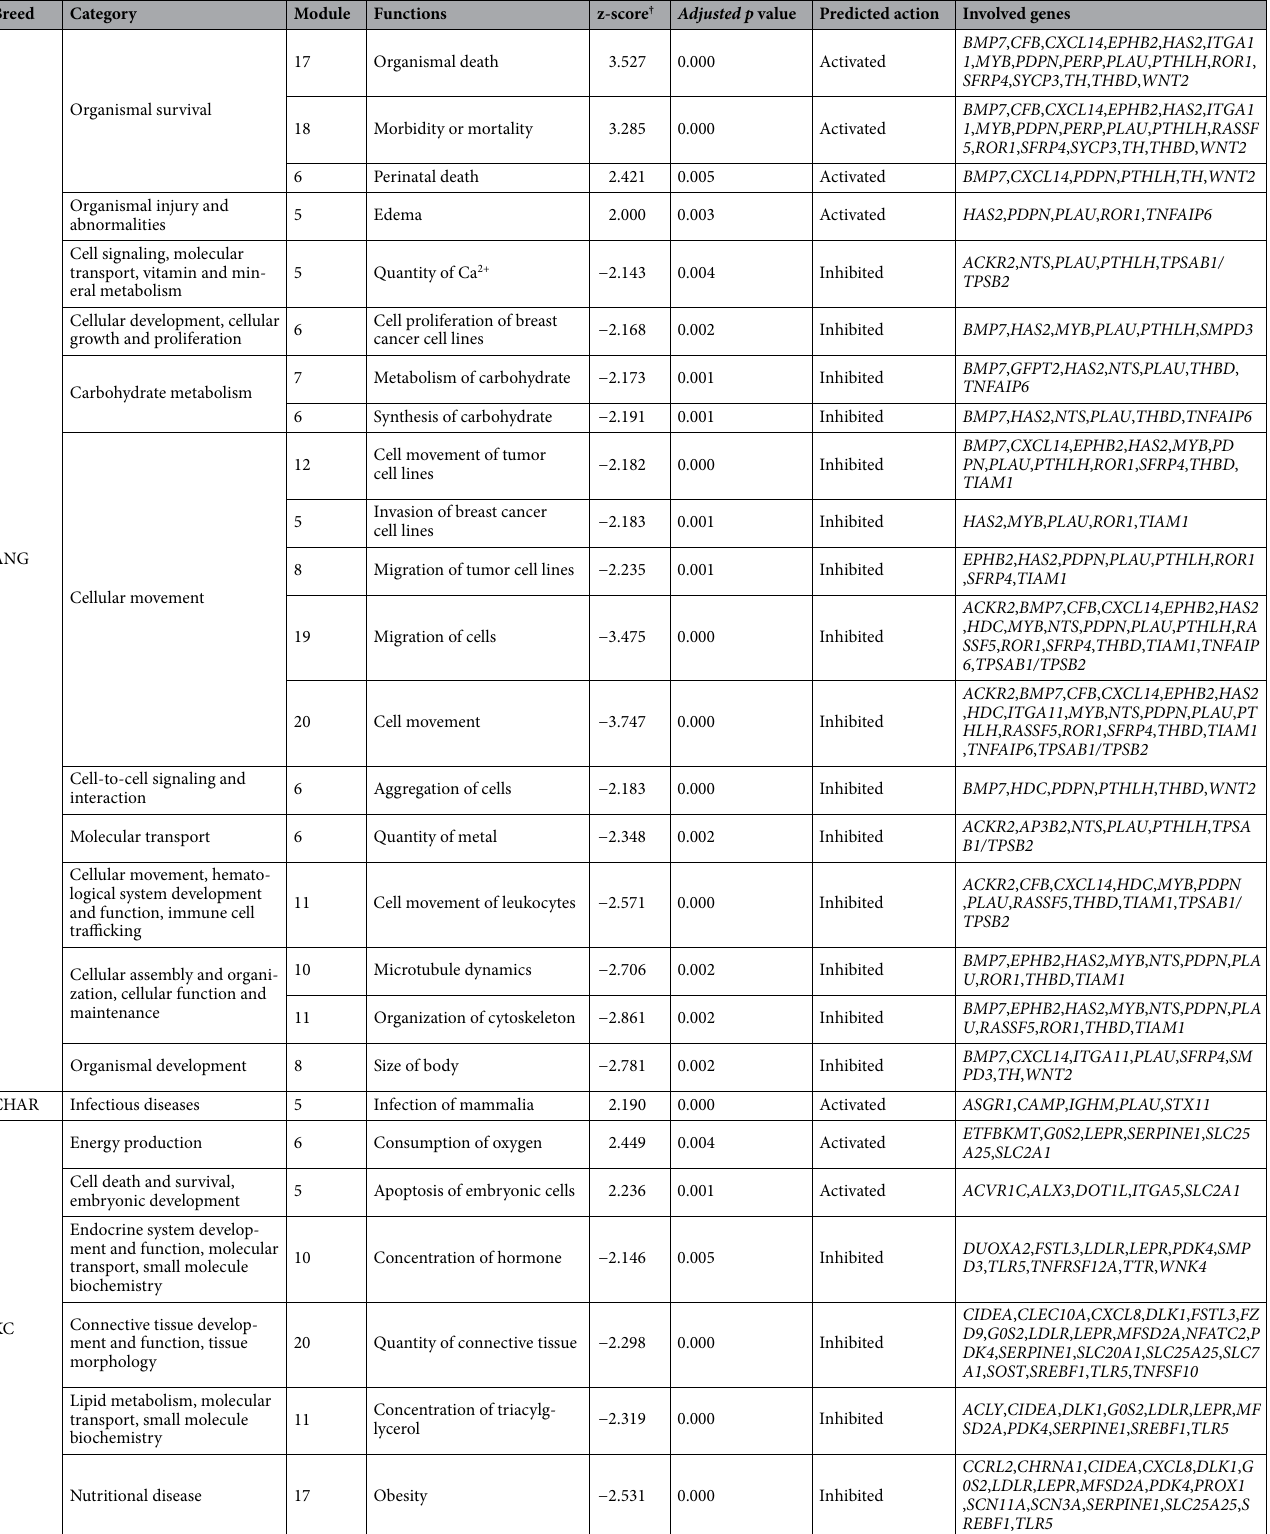
Table 4. GO term enrichment results of all differentially expressed genes using IPA within each breed. † z-score ≥ 2 and z-score ≤ − 2 indicate Activated and Inhibited activation